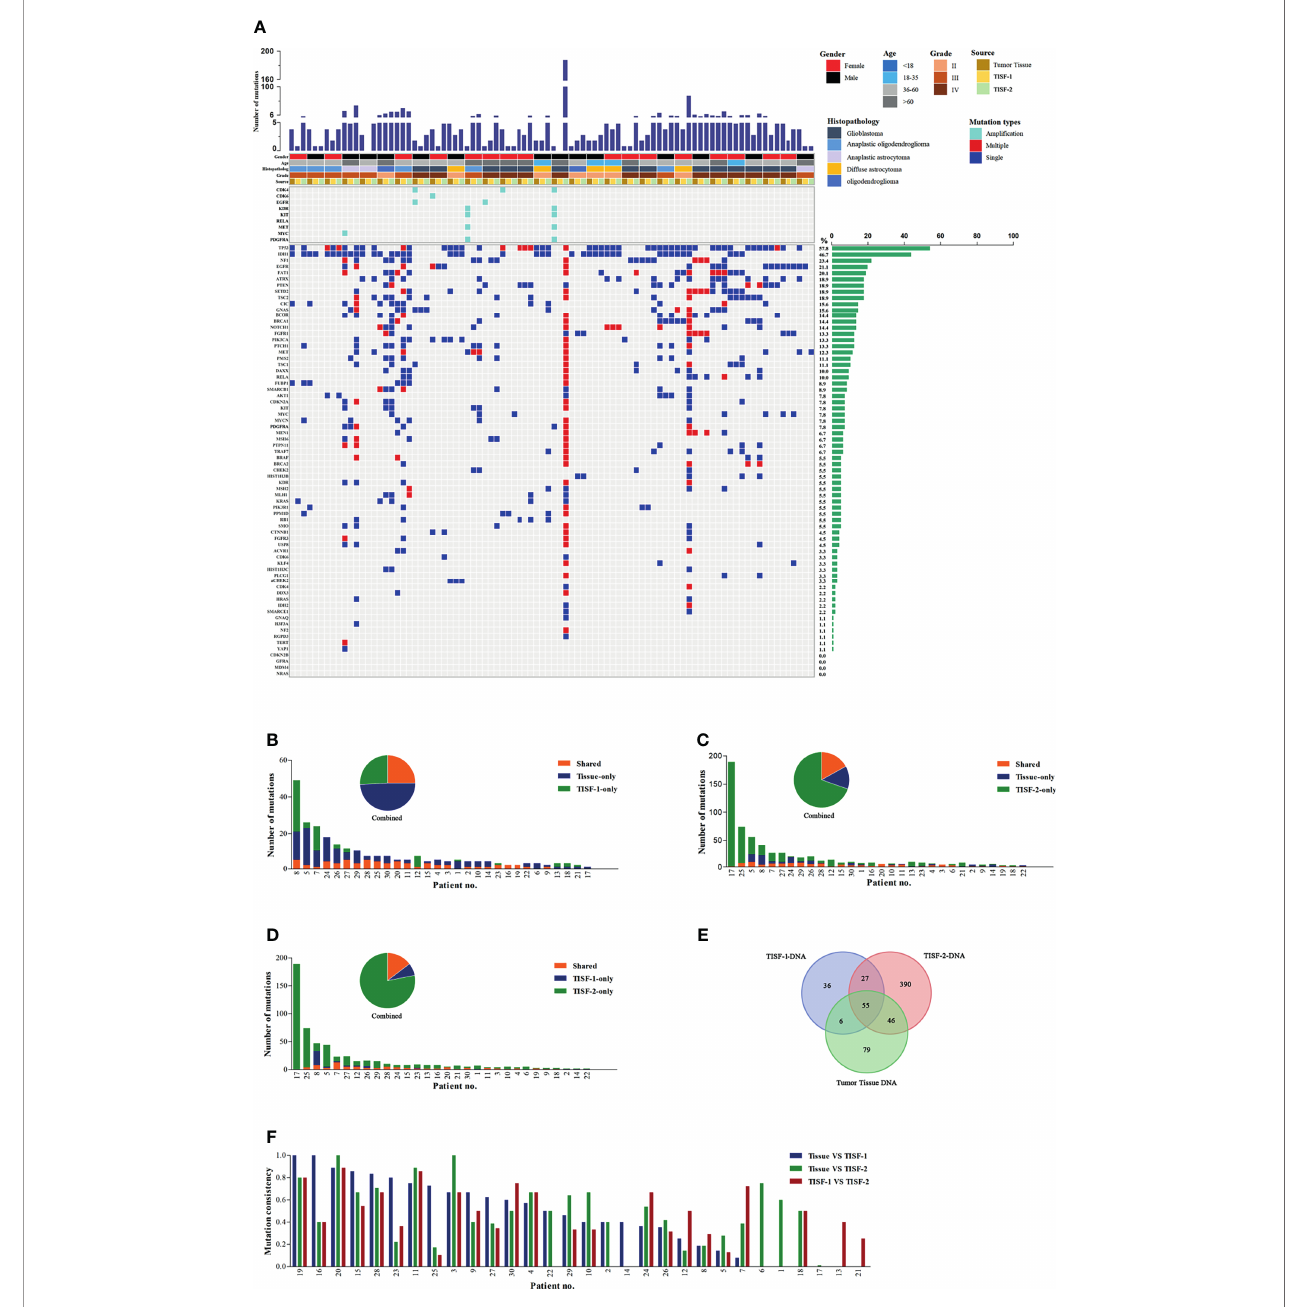
FIGURE 2 | Mutant landscapes in tumor tissue and TISF. (A) Tumor DNA from the patient ’ s tumor in situ fl uid was successfully isolated (n = 30). The following histologies were included in our study: glioblastoma, anaplastic oligoastrocytoma, anaplastic astrocytoma, diffuse astrocytoma, oligodendroglioma. The most frequently mutated genes included IDH1 , TP53 , NF1 , EGFR , and FAT1 . (B-D) Shared mutations in paired samples of tissue or TISF (n = 30). (E) Analysis of the frequency of mutation detected for three times. (F) Analysis of mutation consistency in pairs of TISF samples and matched tumor